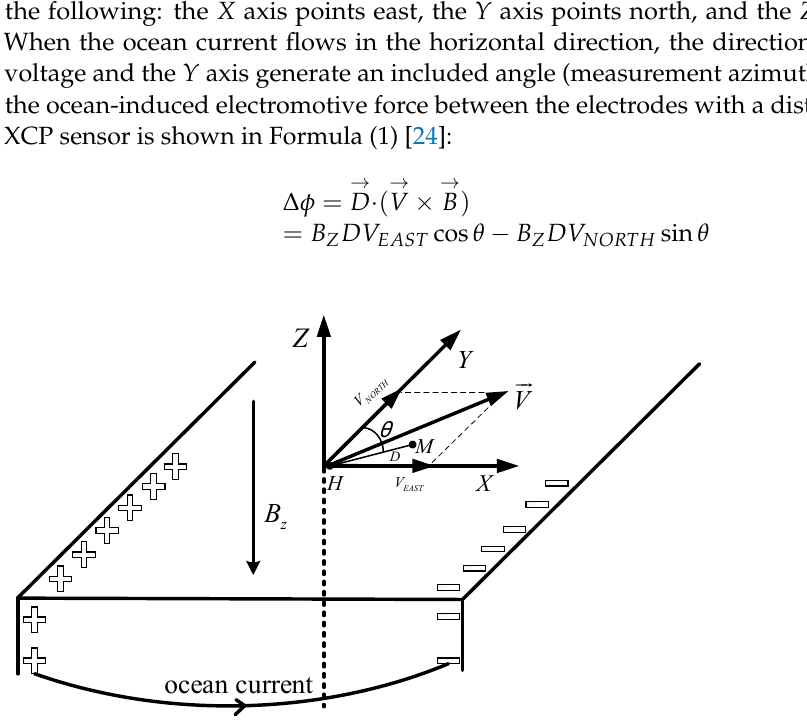
Figure 2. Currents cut by ocean currents. D represents the distance between the two electrodes H and M of the XCP electrode sensor, and θ represents an angle between the measurement direction of the induced voltage and the Y axis.